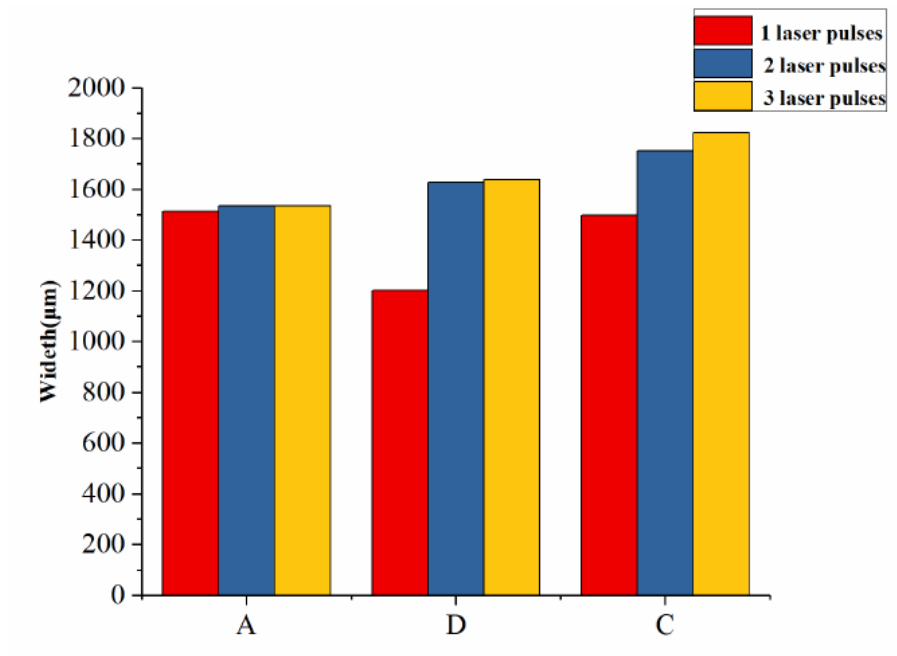
Figure 8. Dimensions A, D, and C of preliminary joints with three different numbers of laser pulses on the upper foil side.